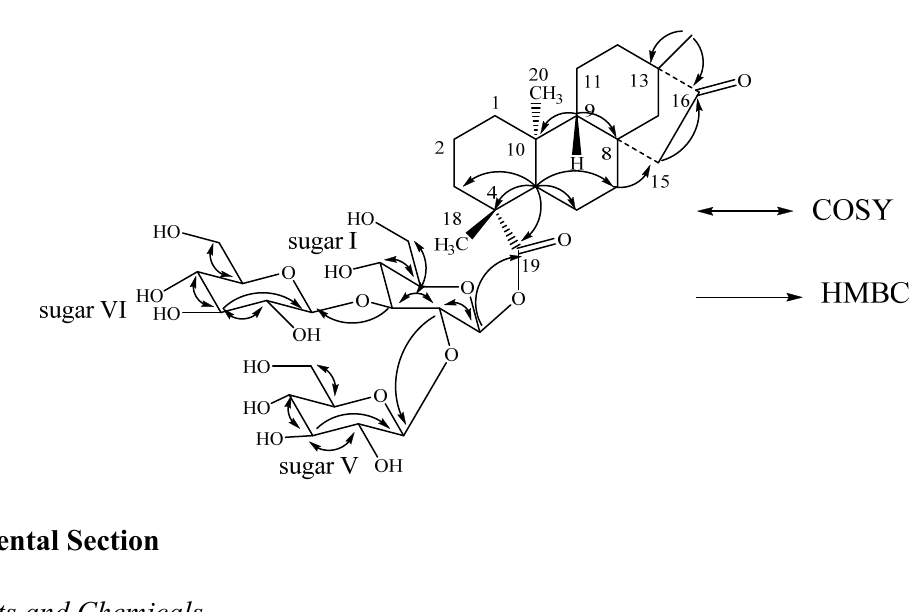
Figure 4. Key COSY and HMBC correlations of 4